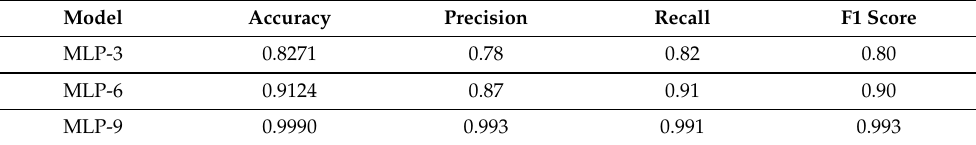
Table 8. Results using the multilayer perception with three, six, and nine layers using KNN imputer.